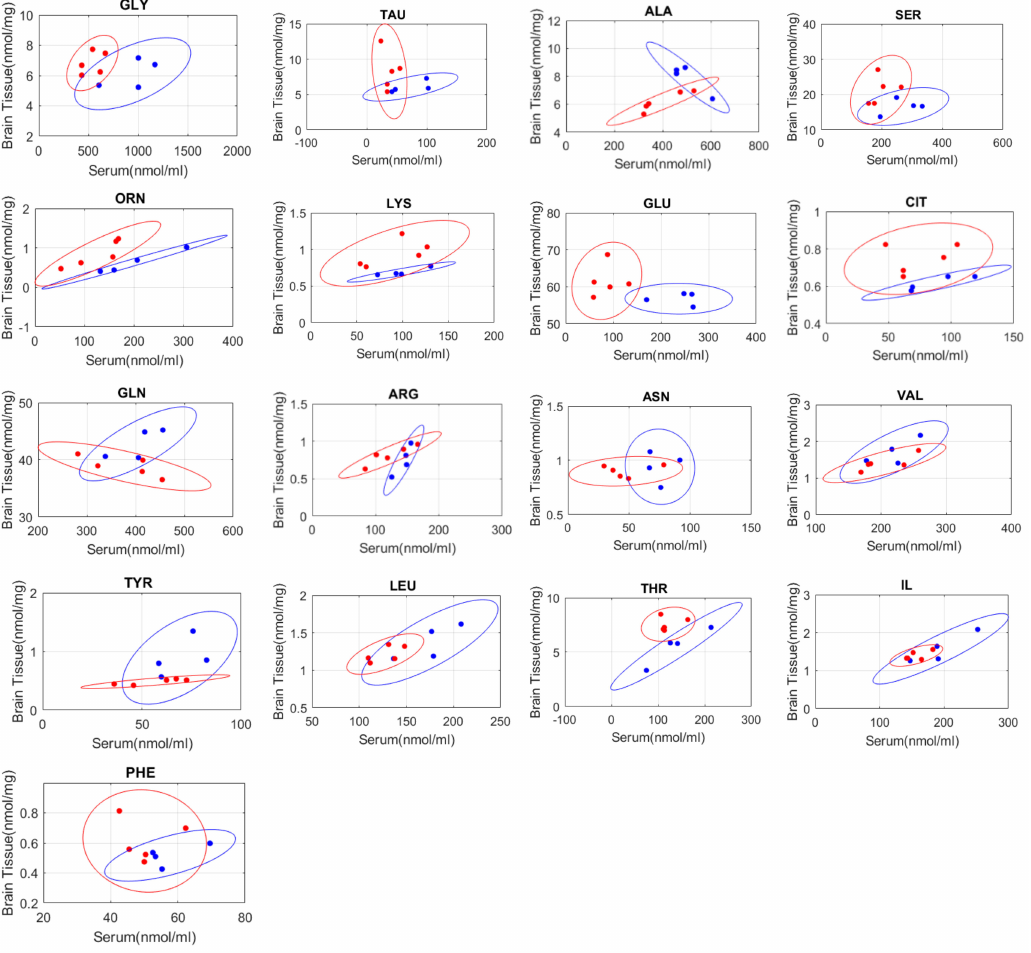
Figure 7. The correlations between serum and brain tissue concentrations of seventeen amino acids and the corresponding 95% confidence ellipses for both healthy / sham (blue markers) and 24 h post-TBI (red markers) groups were shown to explore possible alterations of tissue-serum amino acid concentrations following TBI. These results are based on the Validation Dataset that includes four sham and five TBI